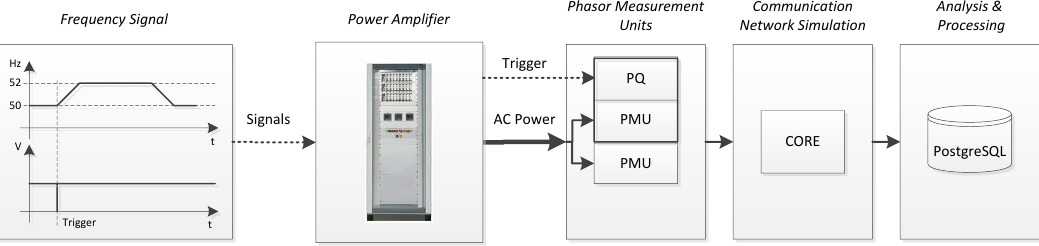
Figure 13. Setup for testing with mains voltage levels by connecting PMUs to AC Power amplifier for e.g., ROCOF